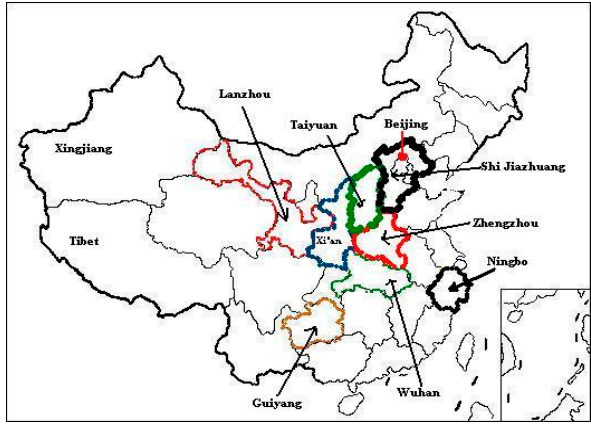
Figure 3. Location of the sample cities in China.